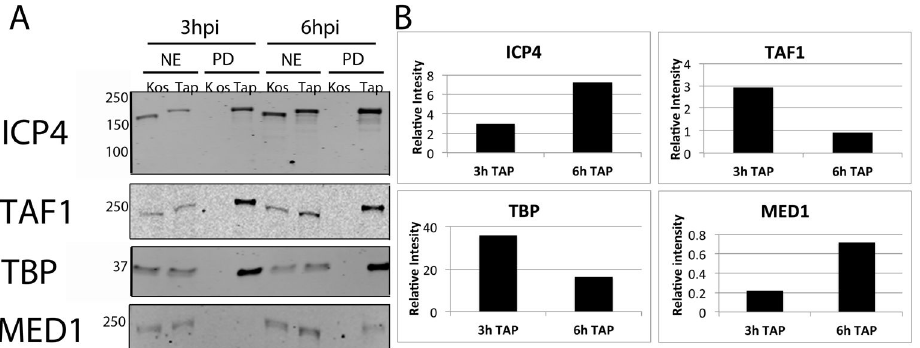
Figure 5. TFIID and Mediator display different temporal associations with ICP4. ( A ) Western blot analysis of nuclear extracts (NE) or affinity purified (PD) samples collected at either 3 hpi or 6 hpi using either wtICP4 (KOS) or TAP-wtICP4 (TAP) expressing viruses. Antibodies directed against ICP4, TAF1 and TBP of TFIID, and Med1 of Mediator were used. ( B ) Quantification of the western blots in (A). Images were quantified using the LiCOR Odyssey infrared imager and normalized to the amount of ICP4 present within the sample.